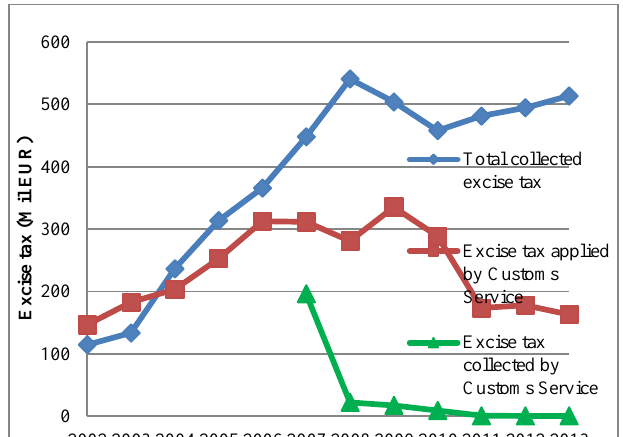
Fig. 3. Excise tax, applied and collected by the Customs Service of Latvia. Source : State Revenue Service. Statistics and performance results.